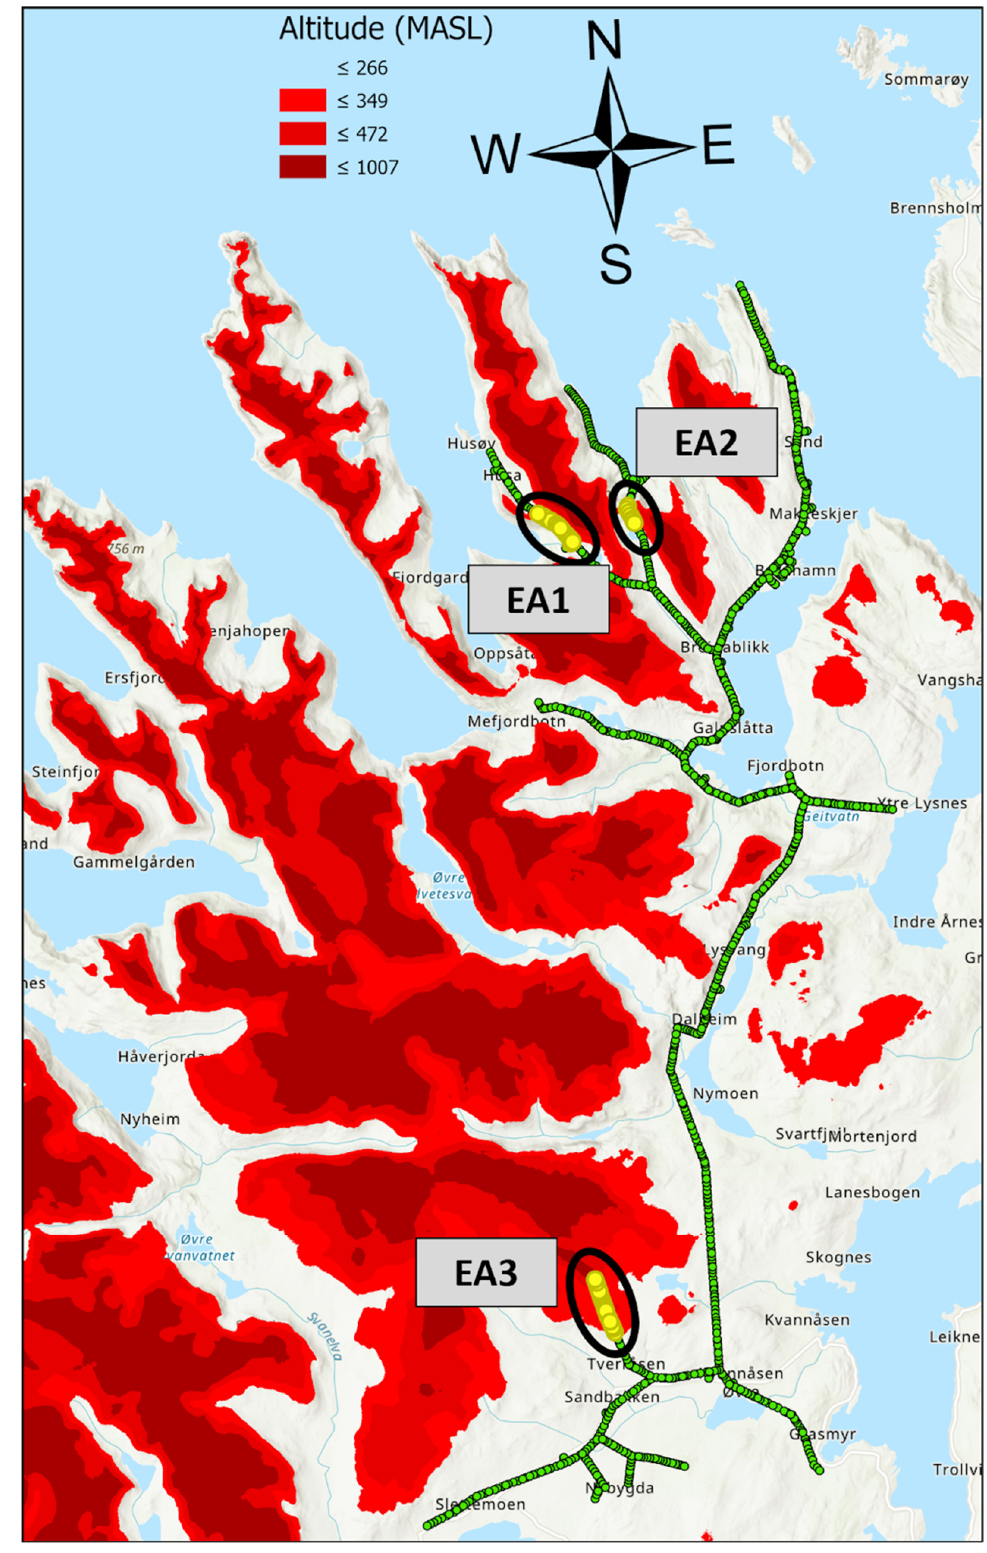
Figure 4. DSM altitude map of the area of interest. The weather-exposed areas (EAs) are highlighted in yellow. in